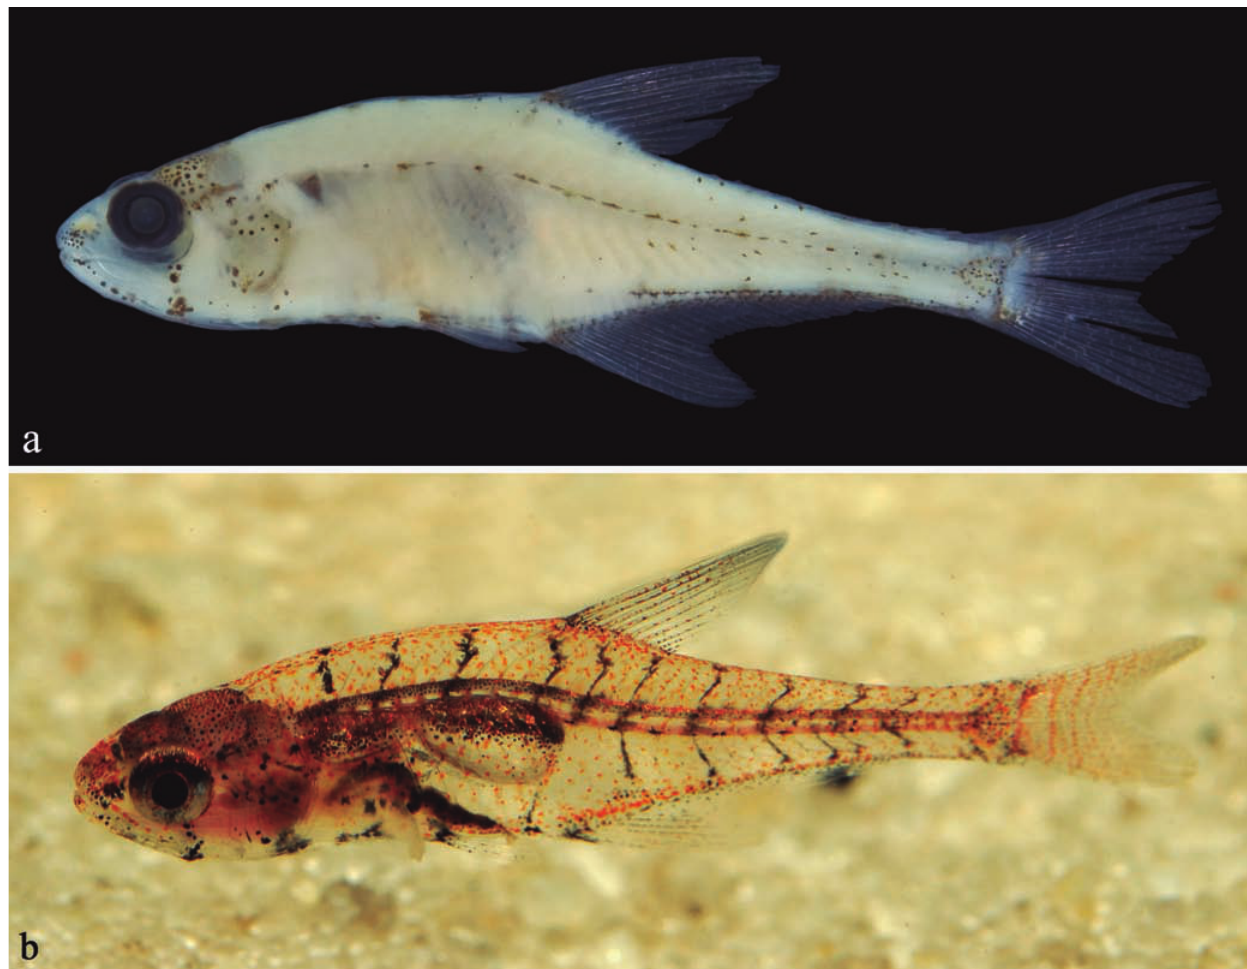
Fig. 1. Priocharax nanus , (a) holotype, MZUSP 114014, 13.8 mm SL; Brazil, Amazonas, Santa Isabel do Rio Negro, rio Negro basin, lake at right bank of rio Urubaxi, near igarapé Tapage; (b) live specimen, one of the paratypes, photographed right after capture. Photograph by Ralf